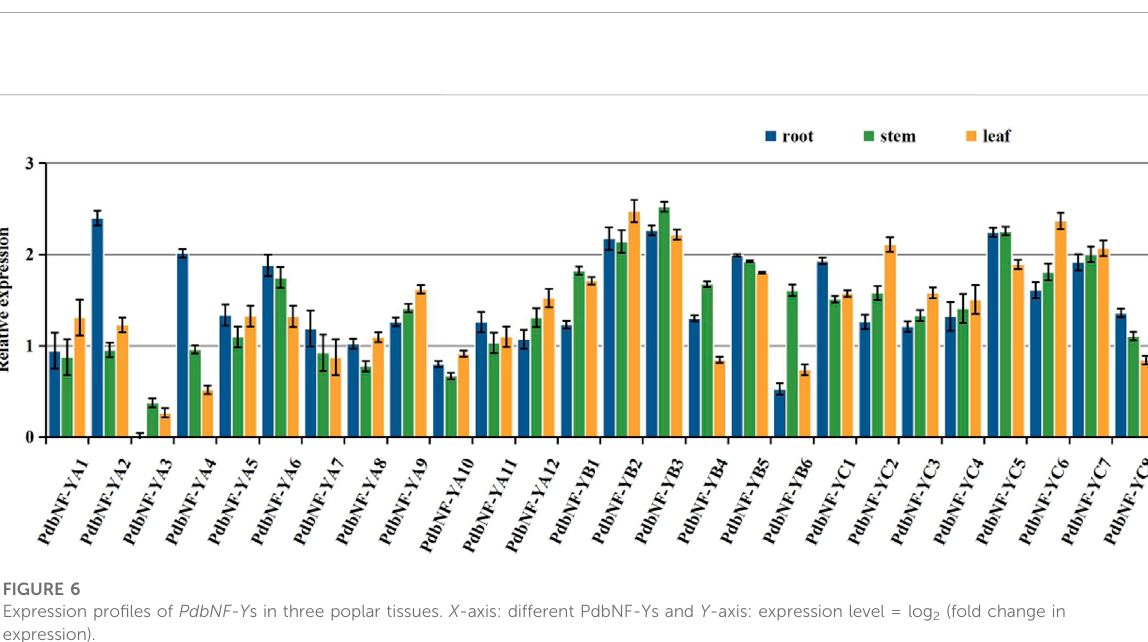
Frontiers in Bioengineering and